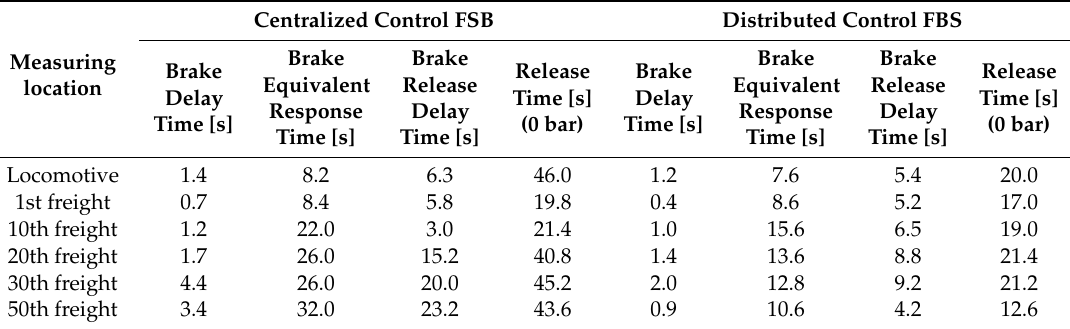
Table A2. Full-service braking results [24].